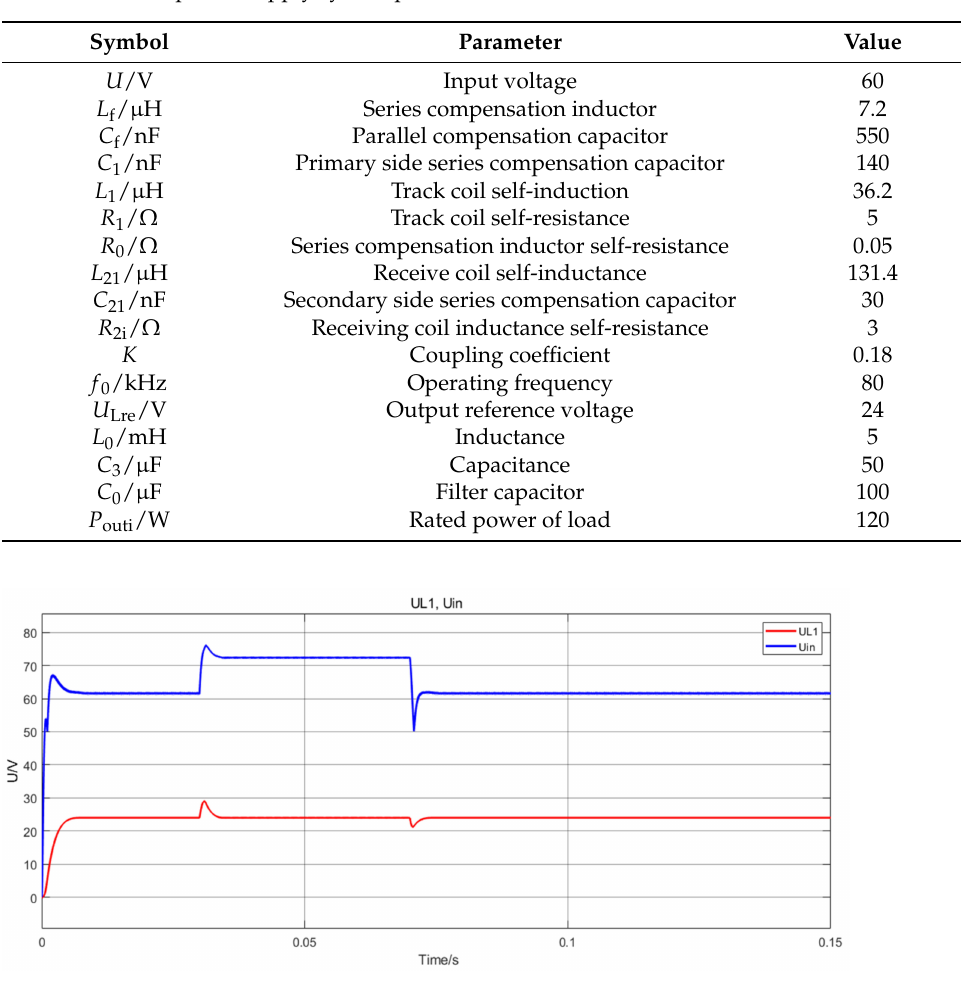
Table 1. Wireless power supply system parameters.